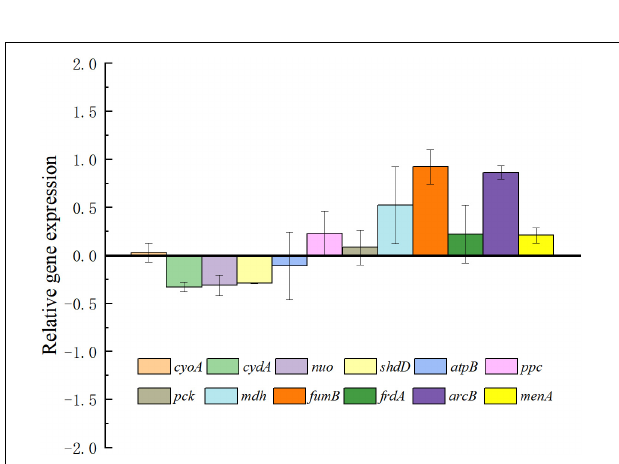
FIGURE 3 | Results of RT-PCR analysis. The transcription pattern was normalized to the reference genes for the expression of E. coli-control . Genes encoding cytochrome bo3 ( cyoA ), cytochrome bd ( cydA ), NADH: ubiquinone oxidoreductase ( nuo ) and succinate dehydrogenase ( sdhD ), ATP synthase ( atpB ), phosphoenolpyruvate carboxylase ( ppc ), phosphoenolpyruvate carboxykinase ( pck ), malate dehydrogenase ( mdh ), fumarate hydratase ( fumB ), fumarate reductase ( frdA ), sensor histidine kinase ( arcB ), and 1,4-dihydroxy-2-naphthoate octaprenyltransferase ( menA ) were analyzed. The unchanged relative gene expression level was calculated as 0. The Y-axis was formatted in a logarithmic scale with base